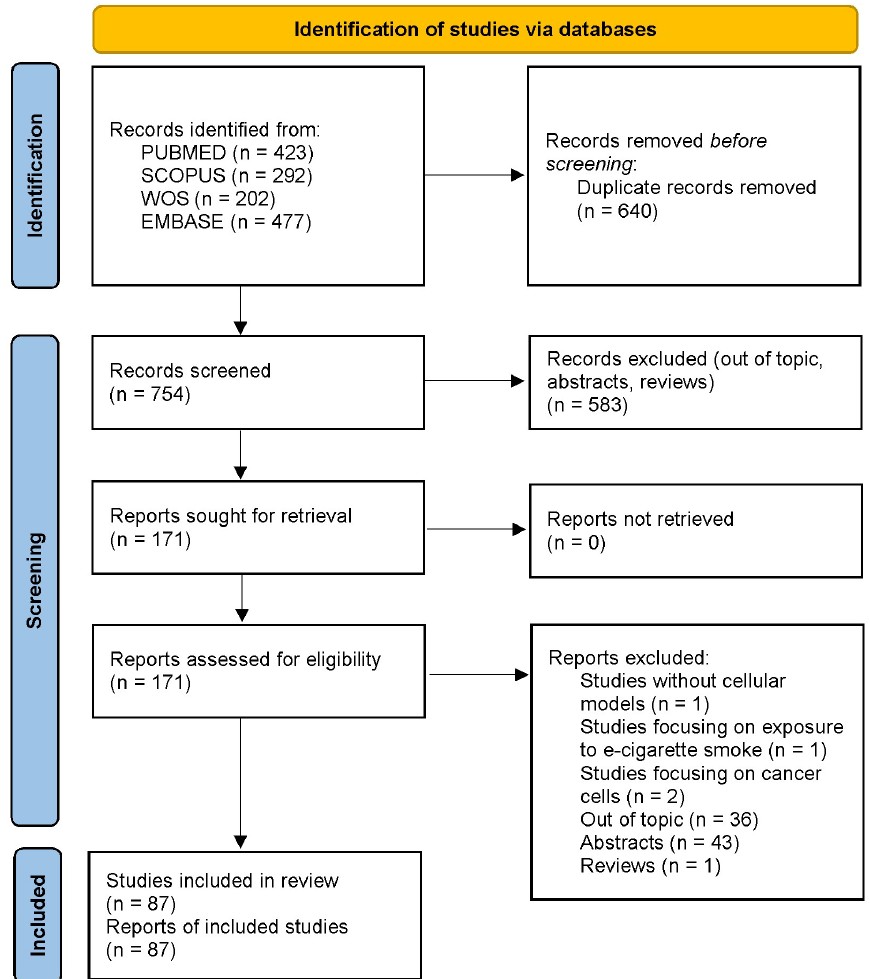
Figure 1. Flow diagram of the study selection process.